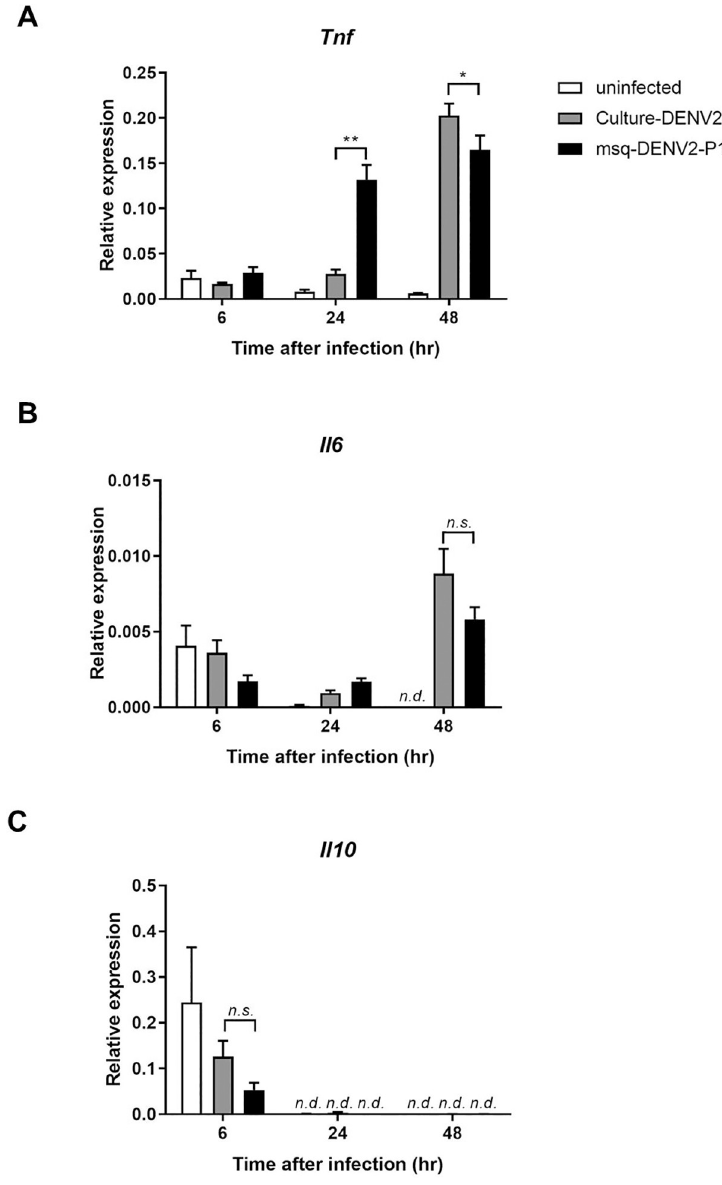
Fig 5. Comparing msq-DENV2 and culture-DENV2 for their ability to induce cytokines in mouse macrophages. Peritoneal macrophages were obtained from Stat1 -/- mice on day 4 after intraperitoneal injection of thioglycollate (Thio-pMac). Thio-pMac were stimulated with culture-DENV2 or msq-DENV2-P1 at a MOI of 20 for 6, 24 or 48 h. RNA was extracted, reverse-transcribed to cDNA for real-time PCR quantitation. mRNA of each cytokine was normalized against mouse Gapdh . n = 4 for each group for each time point. n . s . = non-significant, ��� p < 0.005, as analyzed by one-way ANOVA with Dunn’s multiple comparisons test comparing cytokine levels induced by culture- DENV2 and msq-DENV2-P1 from different time